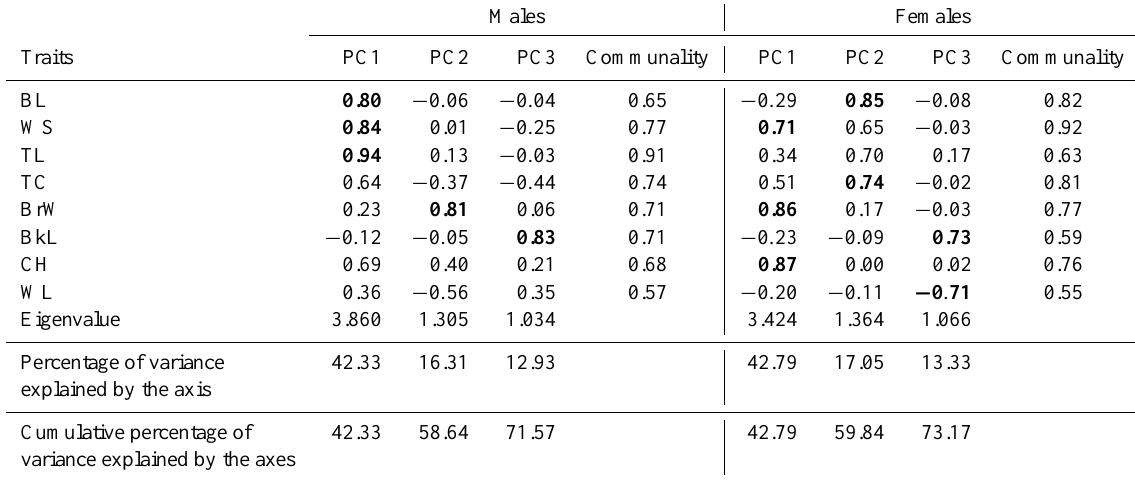
Table 6. Eigenvalues and share of total variance along with factor loading and communalities for eight linear body measurements of male and female chickens. Bold indicates variables with a strong association ( | r | > 0 . 7) with the principal component. Males